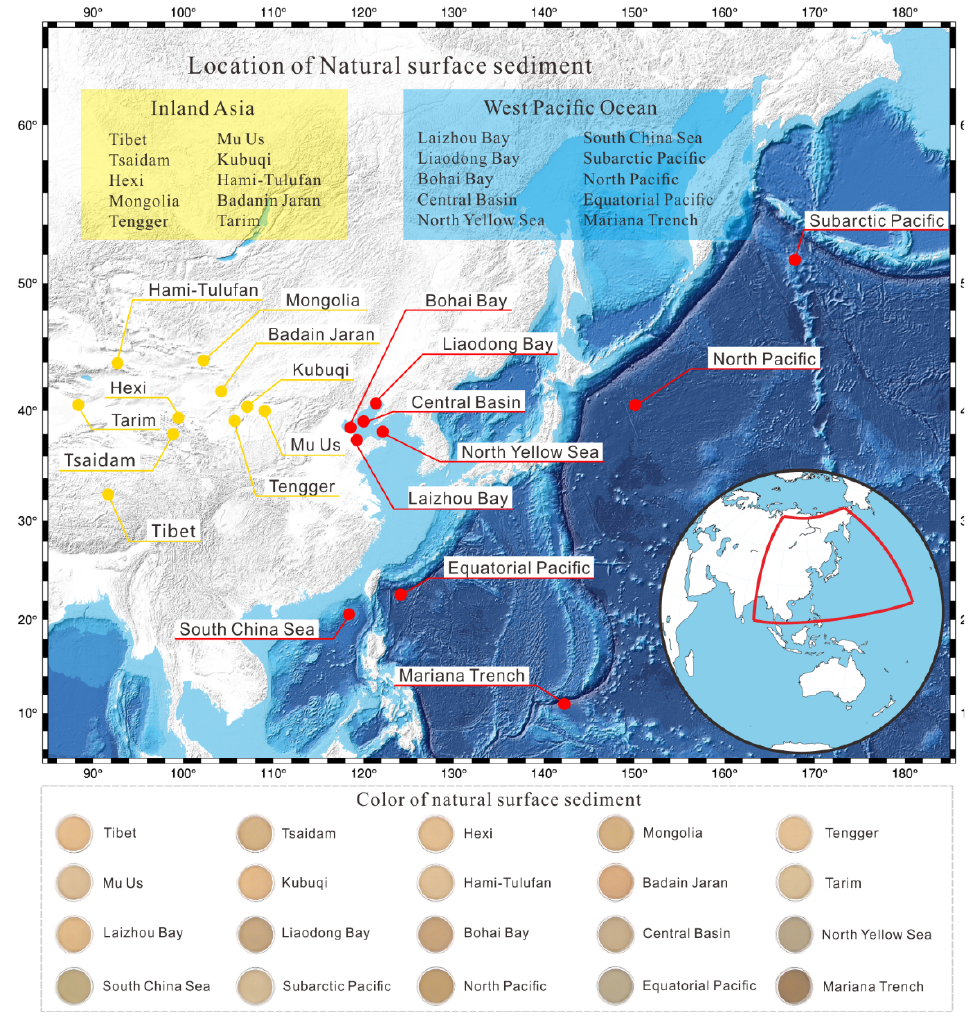
Figure 2. Locations and colors of natural samples (surface sediments from Inland Asia and the Western Pacific Ocean).